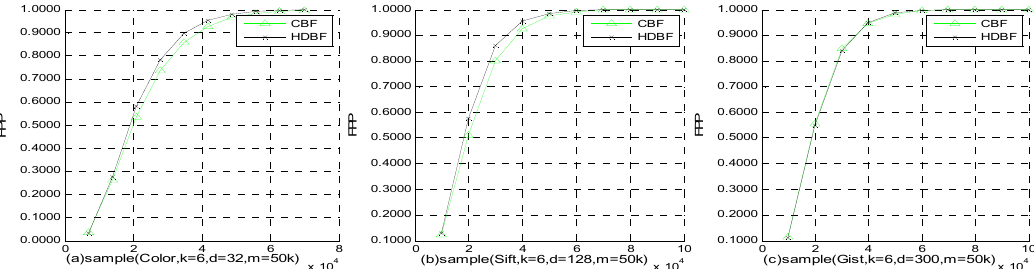
Figure 6. FPPs of the CBF and HDBF for different samples.